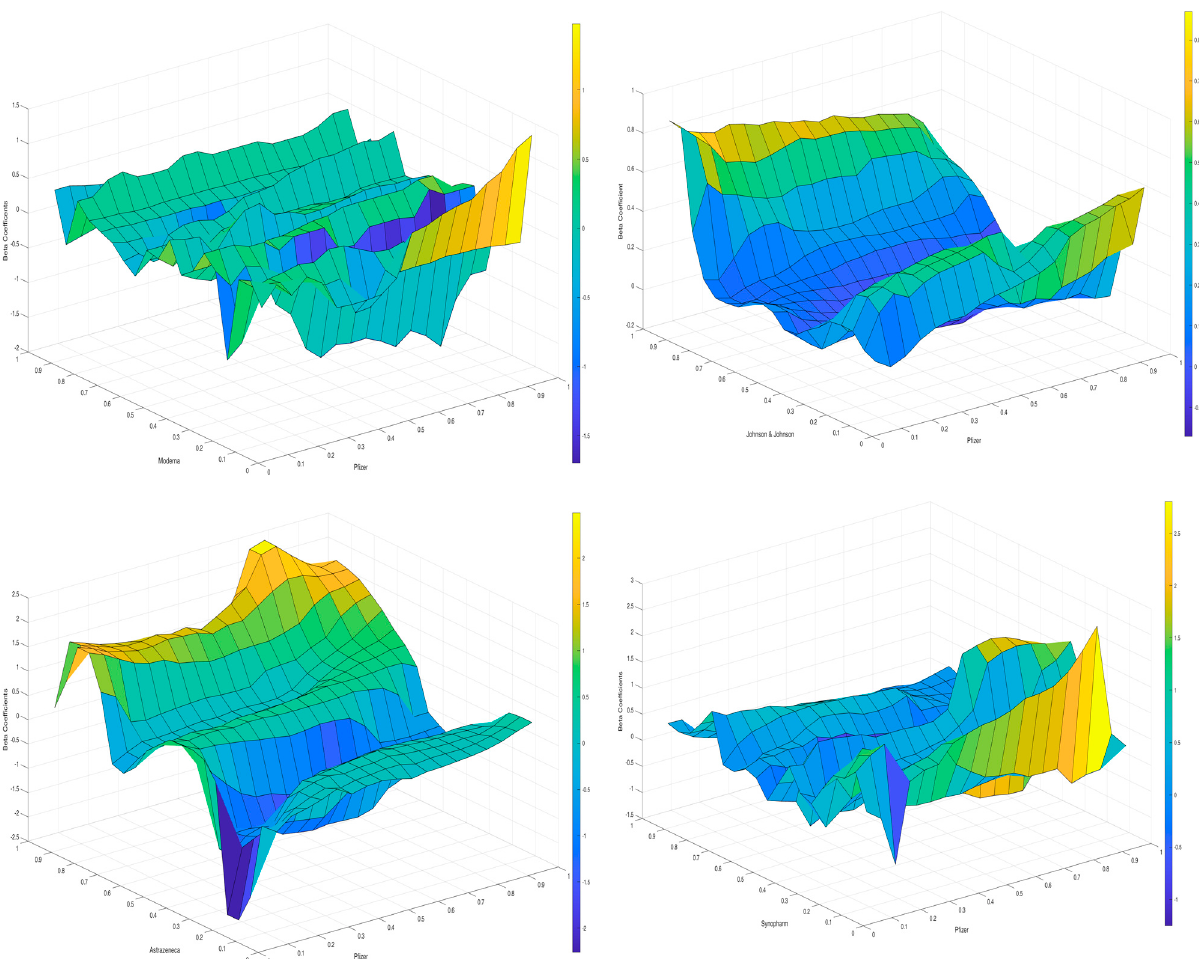
Figure 15. From Pfizer to the other respective markets.